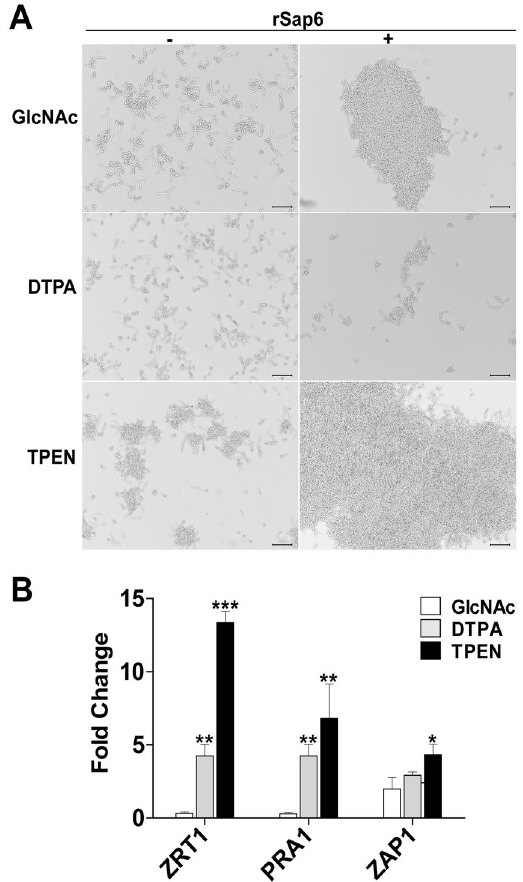
Figure 6. Autoggregation is affected by expression of ZRT1 , PRA1 , ZAP1 , along with extracellular zinc. ( A ) In order to induce increased expression of zinc acquisition genes, cells were incubated with an extracellular (DTPA, 100 µ M) or cell permeable (TPEN, 10 µ M) zinc chelator and germinated in GlcNAc medium for 3 h at 37 °C, washed and rSap6 (10 µ M) was added. ( B ) Expression levels of ZRT1 , PRA1 and ZAP1 in the presence of DTPA and TPEN were assessed by real time PCR using equal amounts of cDNA. DTPA-treated cells had increased expression levels of ZRT1 , PRA1 , and ZAP1 (grey bars); however Sap6-mediated aggregation was nearly abolished in the absence of extracellular zinc (A, middle panel); showing that extracellular zinc is essential to aggregation. TPEN-treated C . albicans cells with depleted intracellular zinc had the highest transcriptional levels of ZAP1 , PRA1 and ZRT1 (black bars); but addition of Sap6 with restored extracellular zinc resulted in a high aggregation (A, bottom panel) compared to control cells. For each sample real-time PCR was done in triplicate and the experiments were repeated on three independent